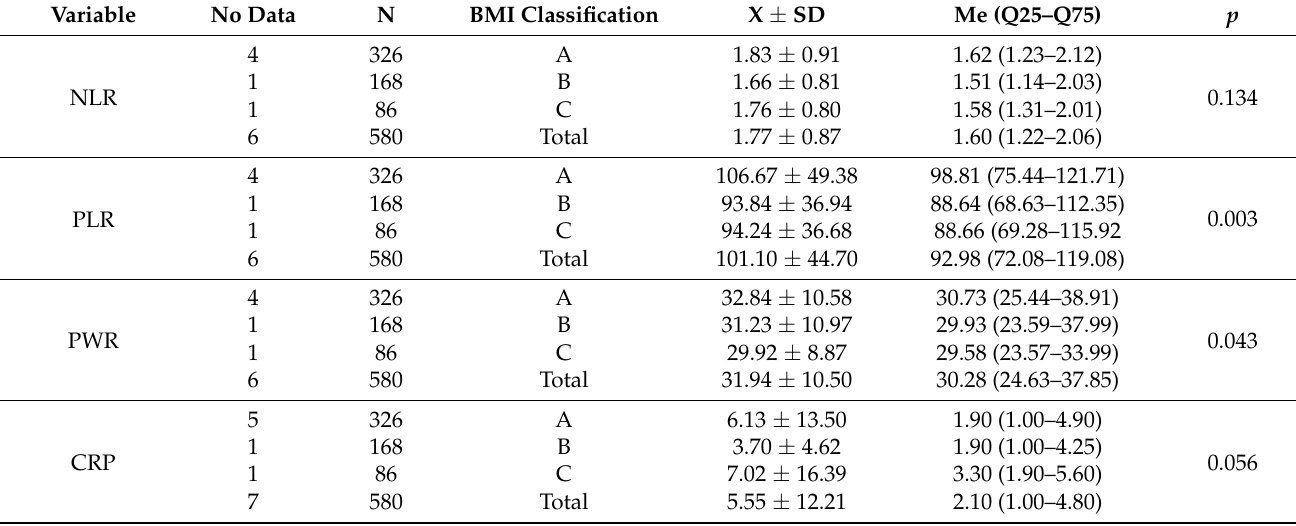
Table 9. Mean values of NLR, PLR and PWR and concentration of CRP in homeless people according to BMI classification.